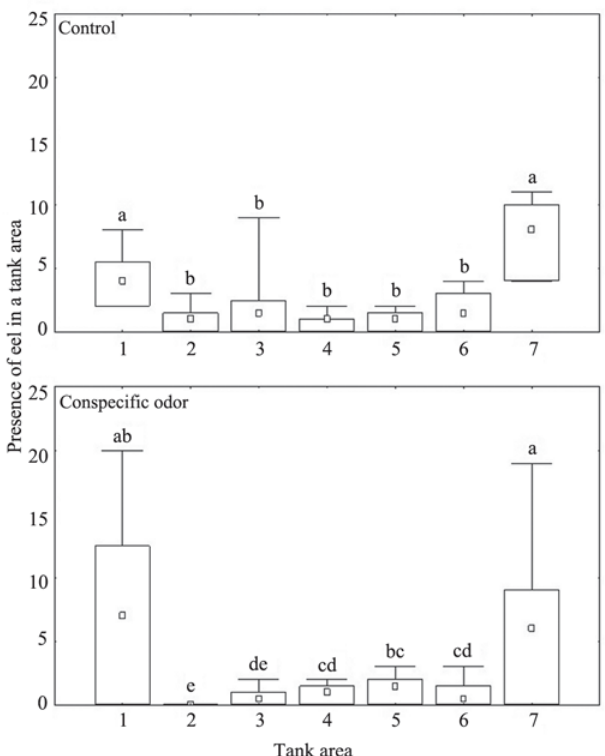
Fig. 2. The effects of conspecific odour on spatial choice in the speckled worm eel Myrophis punctatus . Data are shown as median (small square), minimum and maximum obtained value (lines) and quartiles 25-75% (boxes). The basic strategy of this study was to test eel spatial choice in the presence (Conspecific odour) or not (Control) of conspecific odour on the substrate. Median values that do not share a same letter are statistically different (Friedman ANOVA; p < 0.05).